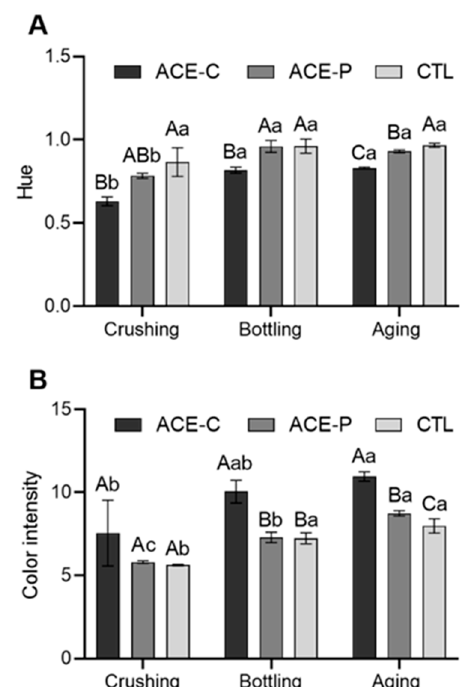
Figure 1. Color characteristics in Marquette grape musts and red wines: ( A ) Hue and ( B ) Color intensity. The error bars represent standard deviation of the mean ( n = 2). Uppercase letters indicate significant difference ( p < 0.05) among treatments within same time point. Lowercase letters indicate significant difference ( p < 0.05) within same sample over time.